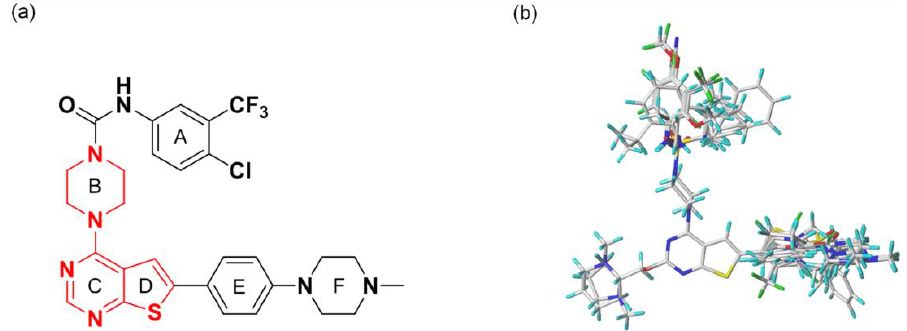
Figure 6. ( a ) The structure of the most active compound 42 as the template including the max- imum common substructure in red; ( b ) The alignment of the training and test sets used in the 3D-QSAR